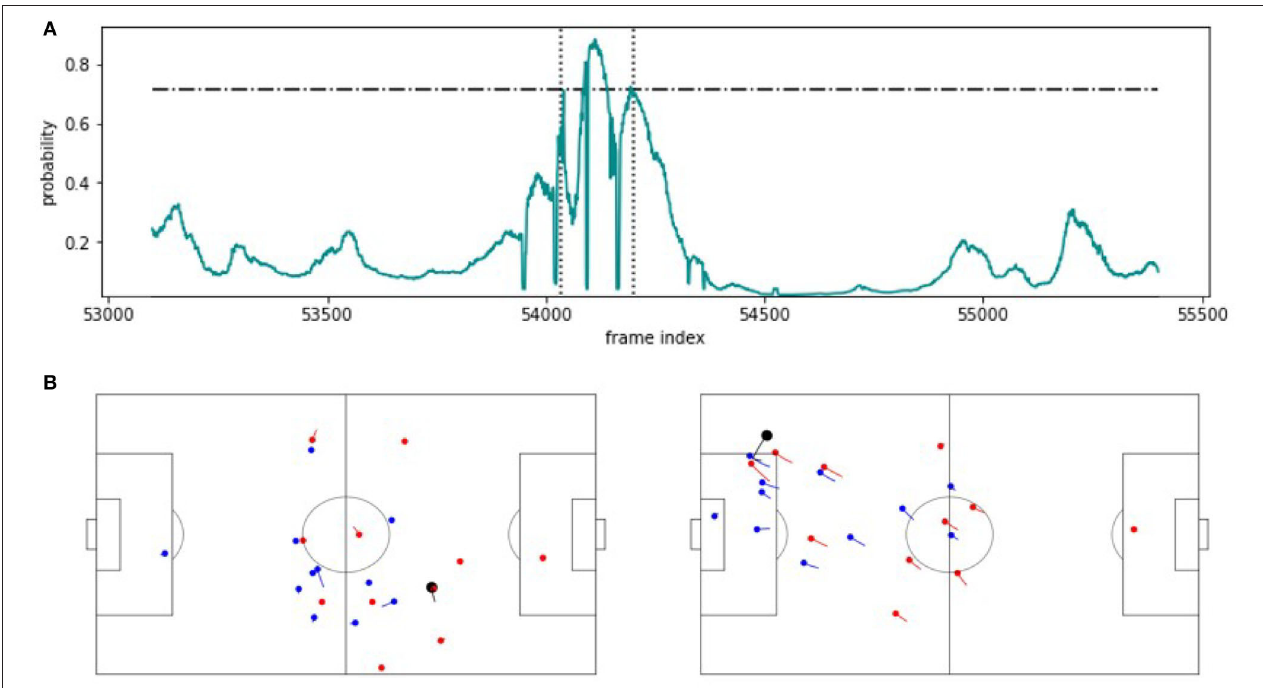
FIGURE 7 | FP example. (A) Predicted probability values for an approximately 100 s excerpt from the validation game. The horizontal line indicates the threshold applied on the probabilities to recognize a counterattack. The vertical lines mark the beginning and the end of the extracted sequence. (B) The corresponding snapshot visualizations for the beginning (left) and the end (right) of the detected scene.